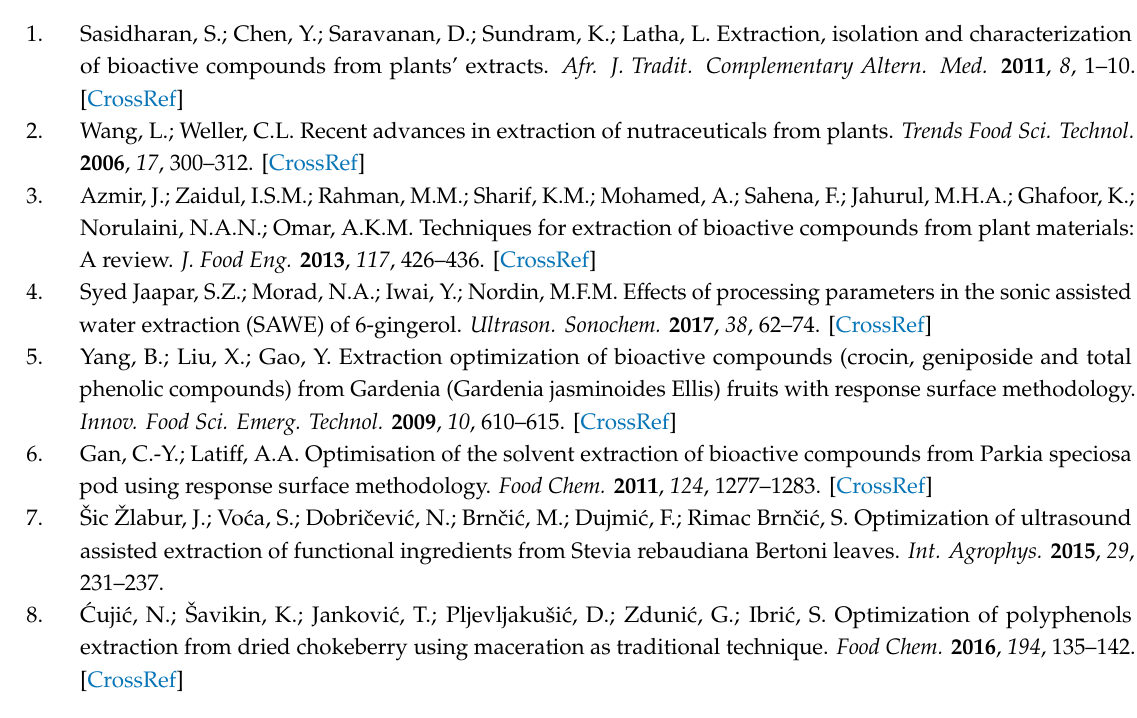
Figure S1: title, Table S1: title, Video S1: